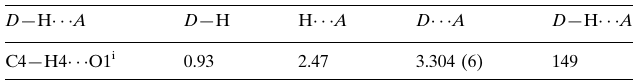
Hydrogen-bond geometry (A˚ , (cid:1)